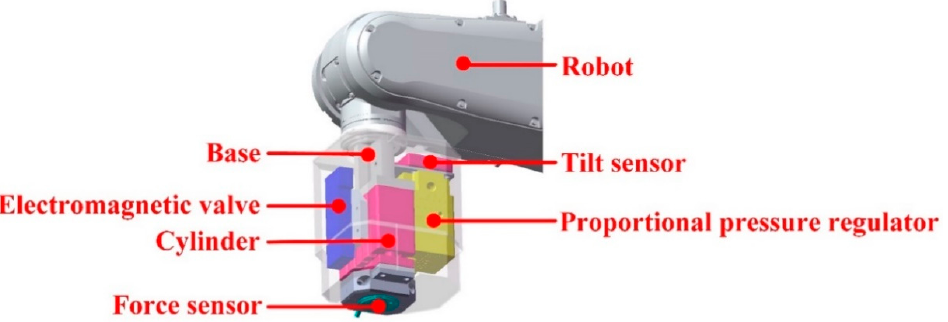
Figure 1. Compliant constant-force actuator structure